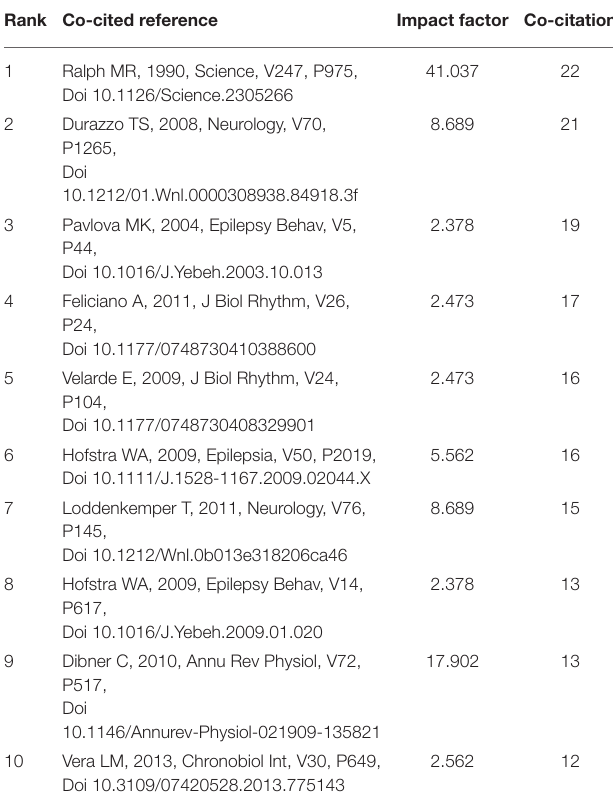
TABLE 3 | The top 10 co-cited references of epilepsy and circadian rhythm.